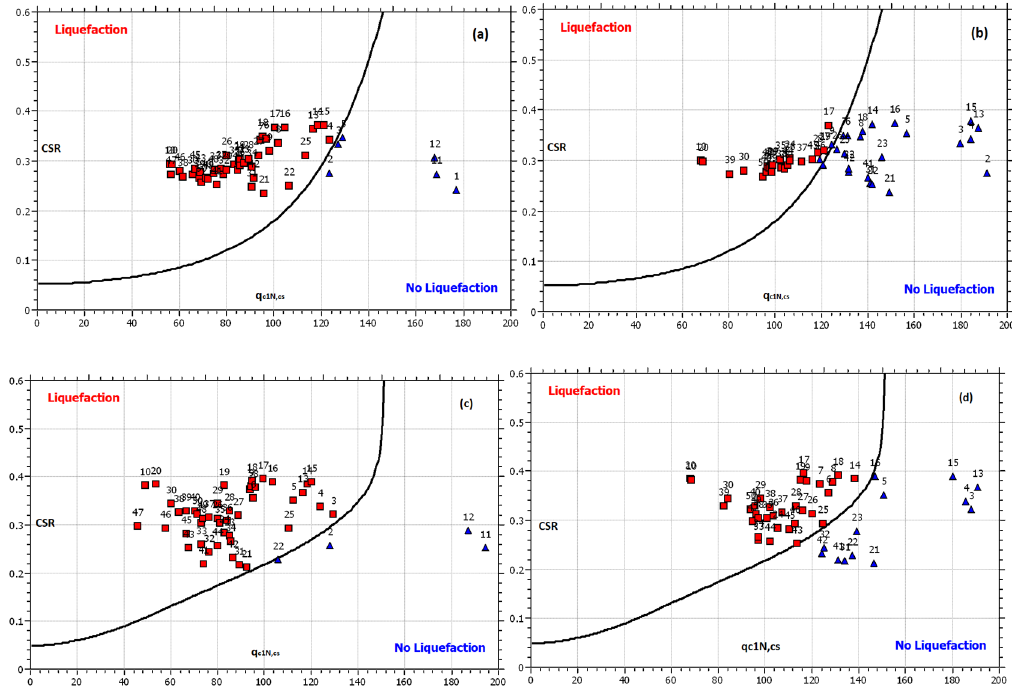
Figure 5. CPT-based liquefaction analysis of clean sand for σ (cid:2973)(cid:2868)՛ = 100 KPa and CRR M = 7.5 , following Juang 2006 recommendations: ( a ) Liquefaction evaluation before jet grouting, ( b ) liquefaction assessment after jet grouting by micropiles and based on the Eurocode 8 specifications, ( c ) liquefaction